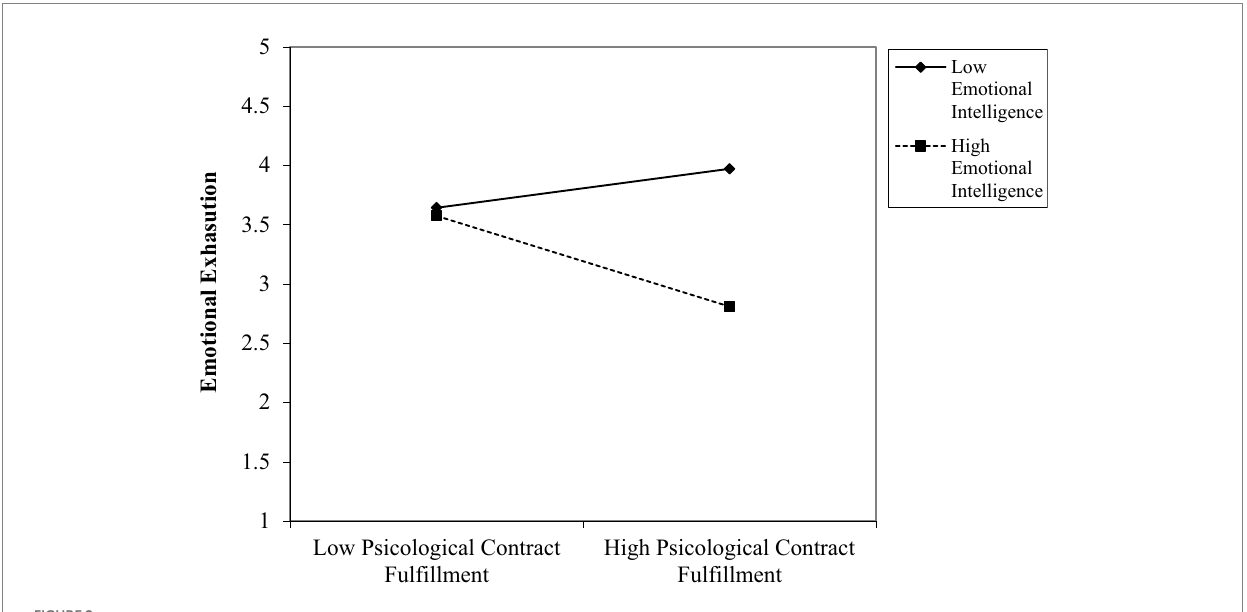
FIGURE 2 Moderation effect of emotional intelligence on PC fulfillment and emotional